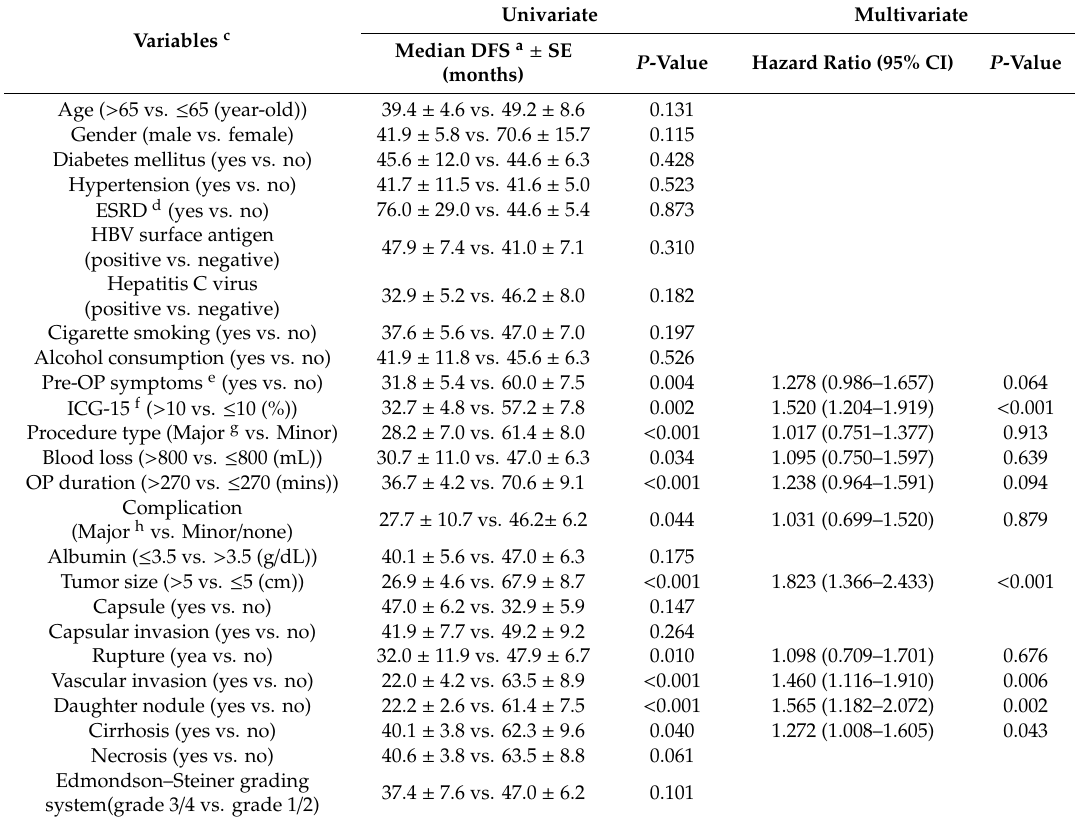
Table 3. Univariate and cox regression multivariate analyses of factors associated with disease-free survival (DFS) a in N-HCC b after